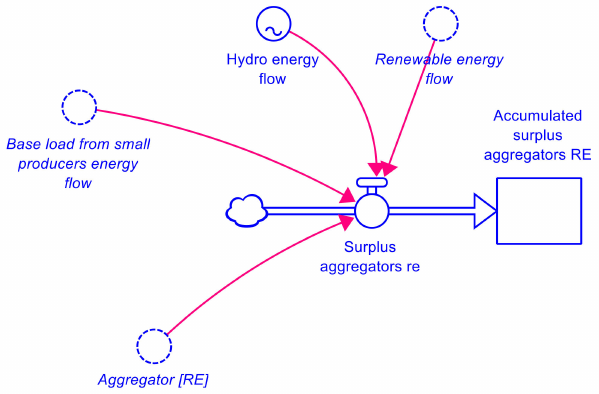
Figure 11. Calculation of surplus energy.